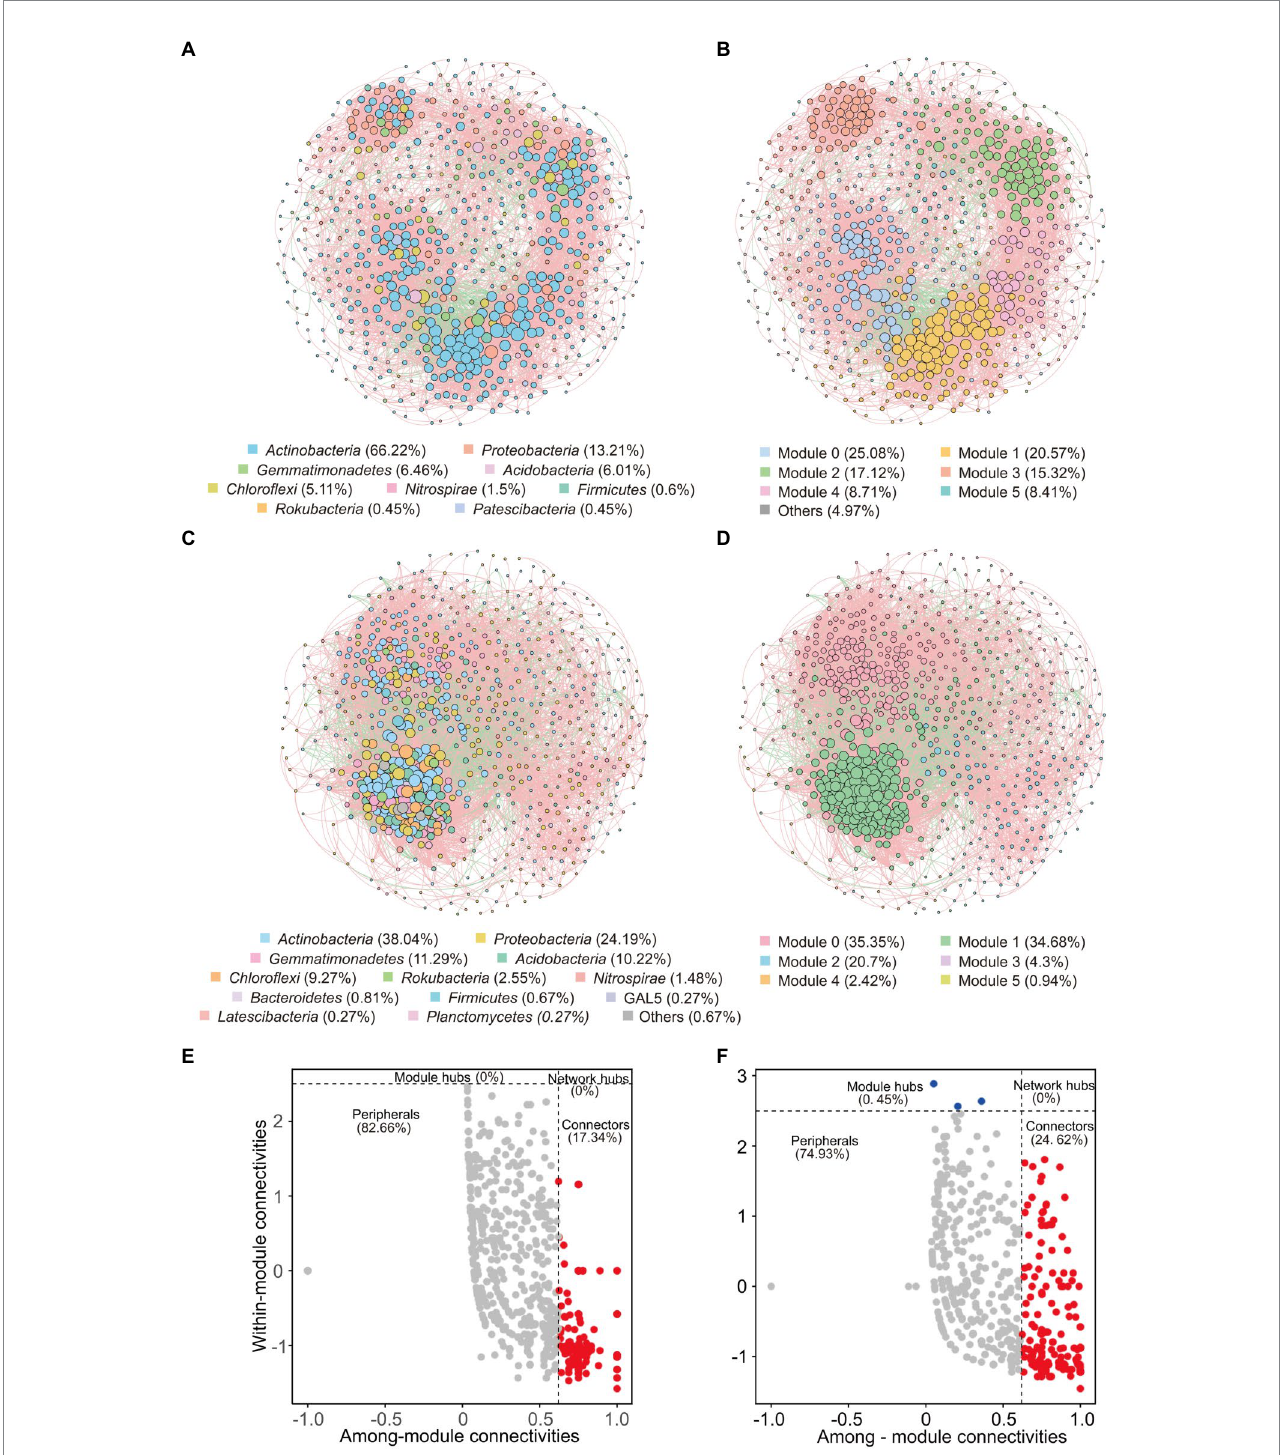
FIGURE 5 Co-occurrence networks of bacterial communities based on pairwise Spearman’s correlations between ASVs with a coefficient > |0.7| and a p -value < 0.01. The upper panel shows the network of weathered rocks with ASVs colored by taxonomy (A) and modularity (B) . The lower panel shows the network of sediments with ASVs colored by taxonomy (C) and modularity (D) . The size of each node is proportional to the number of connections. Red lines represent positive correlations and green lines represent negative correlations. Zi-Pi plots showing the distribution of ASVs with their topological roles in bacterial network of weathered rock (E) and sediment (F)